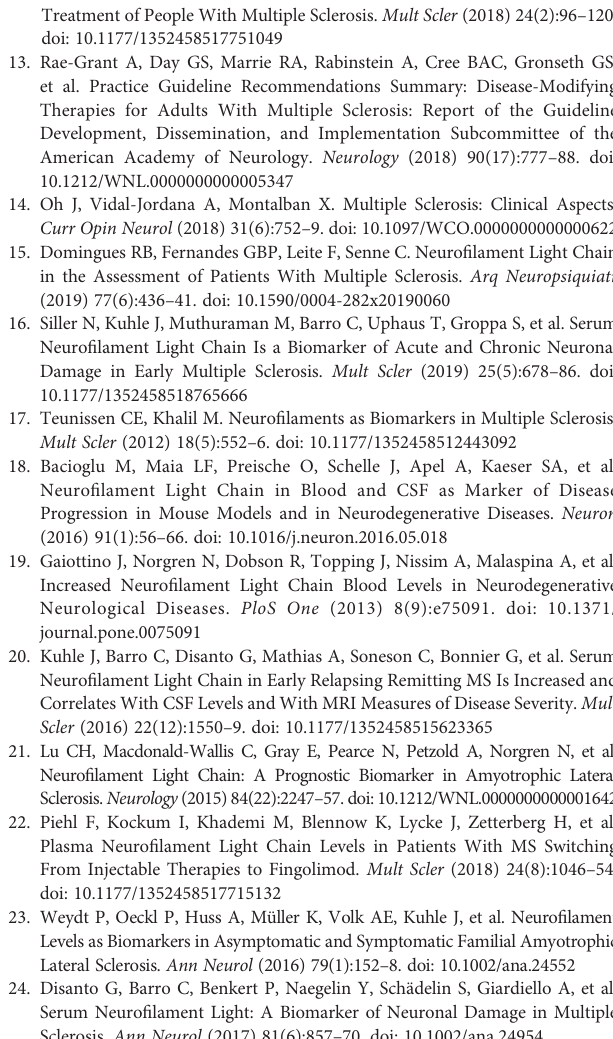
Supplementary Figure 1 | Prognostic value of baseline sNfL category (high [red]: ≥ 9.3 pg/ml, low [green]: <9.3 pg/ml) on the annualized rate of neT2 lesion formation per year in patients (A) with Gd+ T1 lesions and (B) without Gd+ T1 lesions. Comparisons are between high vs low sNfL categories. 1 Adjusted annualized mean rate of neT2 lesions. The number of neT2 lesions (compared to baseline) was analyzed in anegative binomial model withadjustments for treatment, baselinesNfL